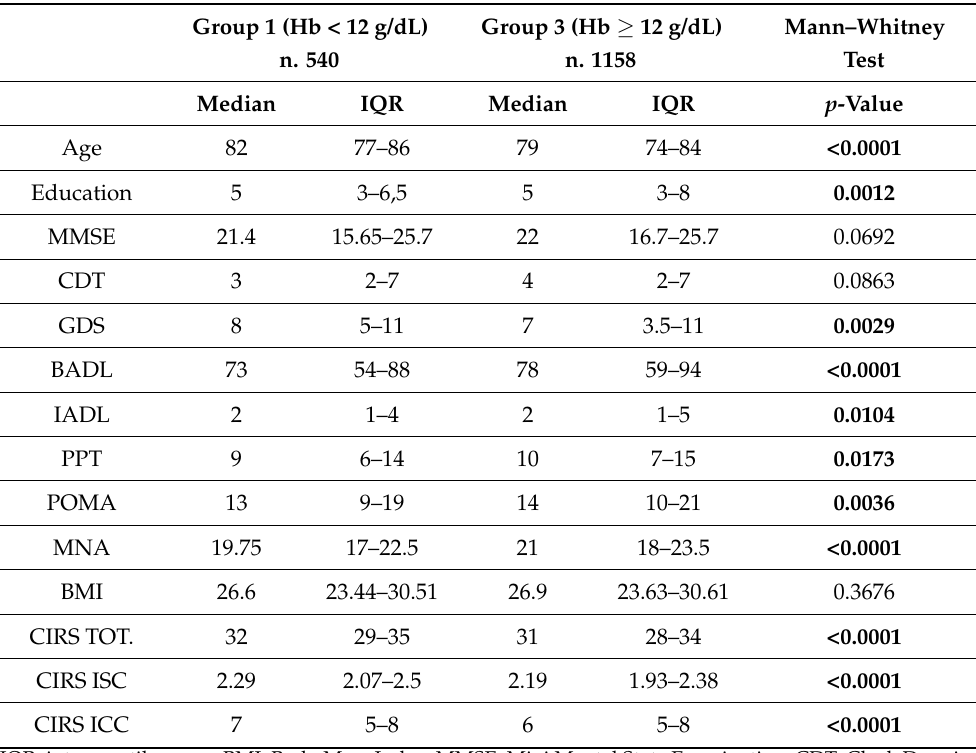
Table 6. Anemic group vs. non-anemic group (cut-off: Hb < 12 g/dL). Group 1 (Hb < 12 g/dL) Group 3 (Hb ≥ 12 n. 540